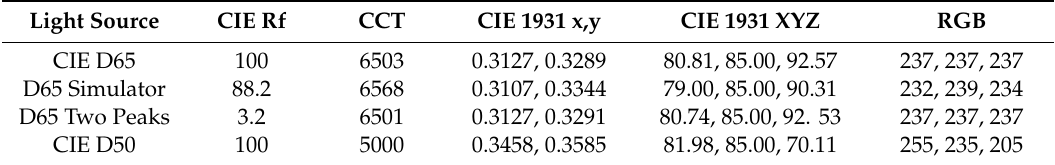
Table 3. Numerical characterization of the light sources used in this work: CIE R f, Color Fidelity Index; Correlated Color Temperature, CCT; CIE 1931 chromaticity coordinates and tristimulus values; and the RGB values corresponding to the sRGB standard.